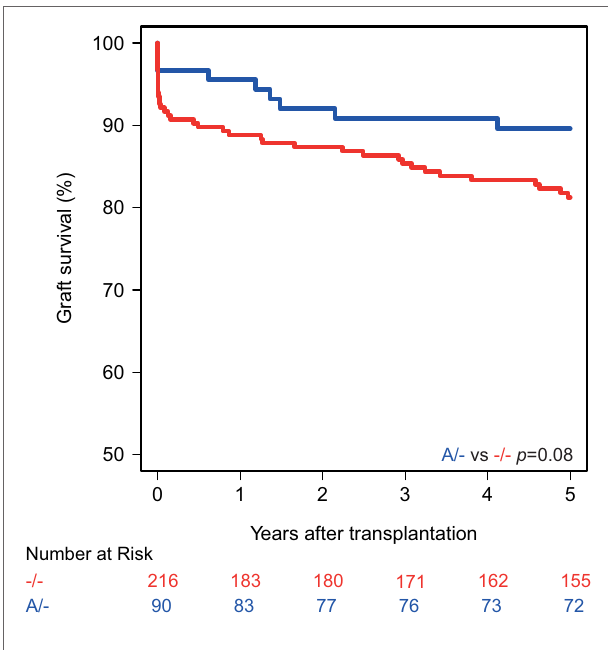
FigUre 1 | Death-censored graft survival curve according to donor CD59 promoter genotype. Kidneys with the − / − single-nucleotide polymorphism configuration tend to have an impaired 5-year death-censored graft survival ( p =